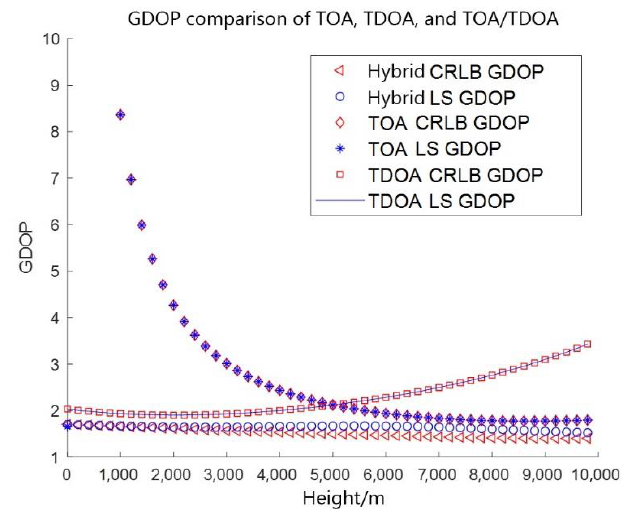
Figure 4. GDOP curves of TOA, TDOA, and TOA/TDOA hybrid positioning of line trajectory.